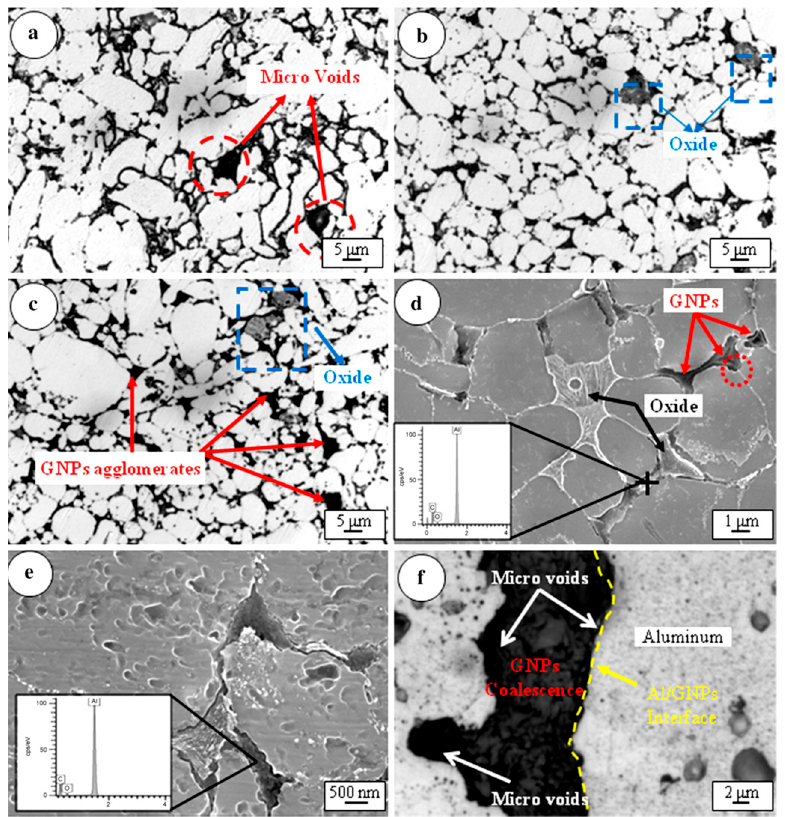
Figure 9. Optical microscopy (OM) micrograph of press-sintered ( a ) pure Al, ( b ) Al-0.5 wt % GNPs, ( c ) Al-1.0 wt % GNPs, ( d ) scanning electron microscopy (SEM) image of Al-1.0 wt % GNPs, ( e ) EDS analysis at a grain boundary, ( f ) a representative grain boundary of Al-1.0 wt % GNPs after sintering [131], Reproduced from [131], with permission from Springer Nature, 2017.